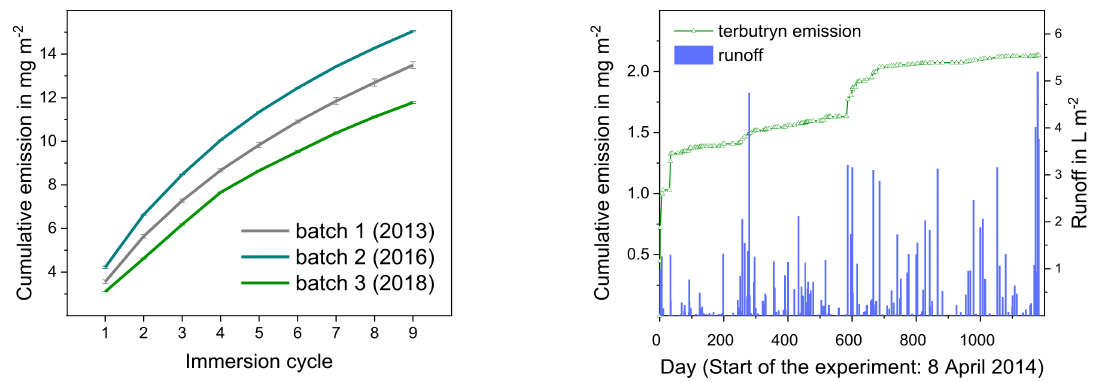
Figure 2. Emission of the biocidal active substance terbutryn from painted wood (1) in laboratory experiments according to EN 16105 [39] using three different batches of paint and (2) during an outdoor experiment (data from [27], completed by unpublished data). Error bars in the left graph indicate minimum and maximum values of parallel